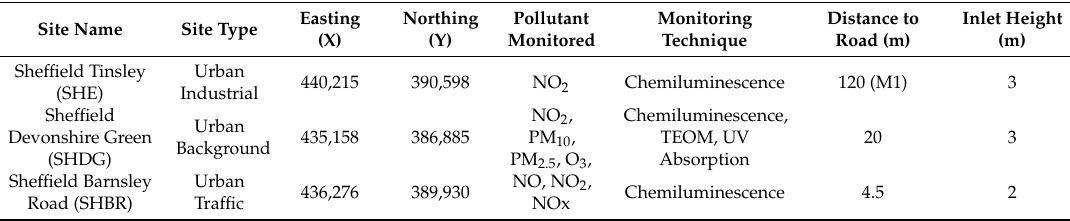
Table 2. Air quality monitoring sites (receptor points) where measured and modelled concentrations are